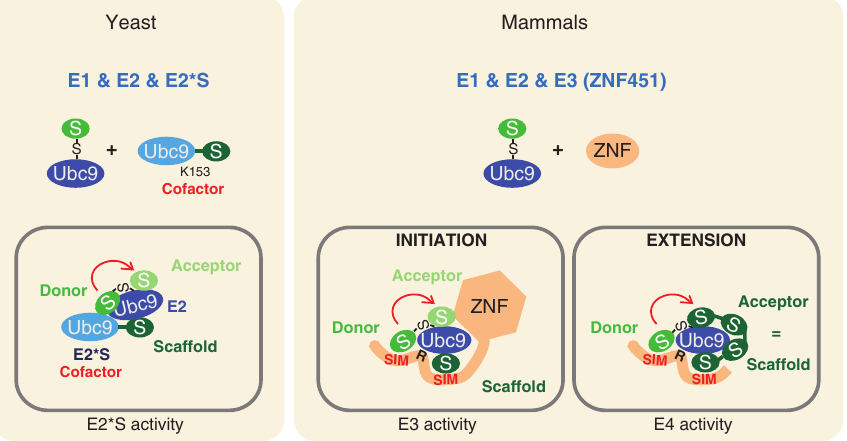
Figure 7: SUMO chain assembly. Two mechanisms of SUMO chain assembly are described. Left panel: SUMO chain formation in S. cerevisiae by a charged Ubc9 and a sumoylated Ubc9. C-terminal Ubc9 sumoylation on Lys153 (Ubc9 in light blue and SUMO in dark green) in S. cerevisiae inactivates Ubc9 in its classical E2 function but turns it into a cofactor for SUMO chain formation. It binds to the backside of a SUMO D -charged Ubc9 (SUMO D in middle green and Ubc9 in dark blue) and positions the donor SUMO D in its catalytic cleft. The acceptor SUMO (light green) binds to the cata- lytic cleft of the loaded Ubc9 (68). Right panel: SUMO chain formation by SUMO D -charged Ubc9 and ZNF451 in mammals. The tandem SIM region of ZNF451 family members (salmon) is sufficient to extend a short SUMO chain (dark green) anchored in the scaffold SUMO B